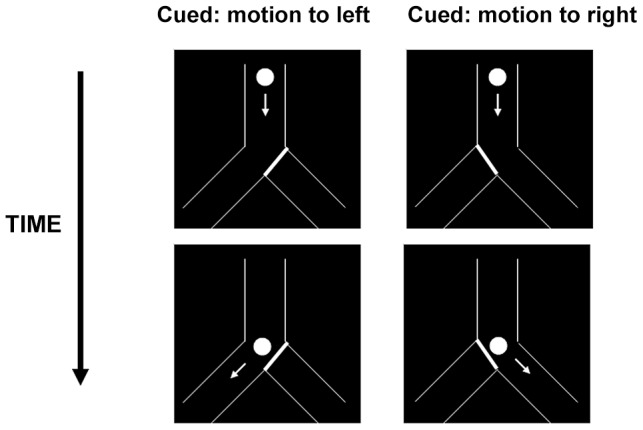
Stimulus Display for Cued Target Motion.The disc moves down the tube and then travels down whichever branch (left or right) is not blocked by the visual barrier cue.